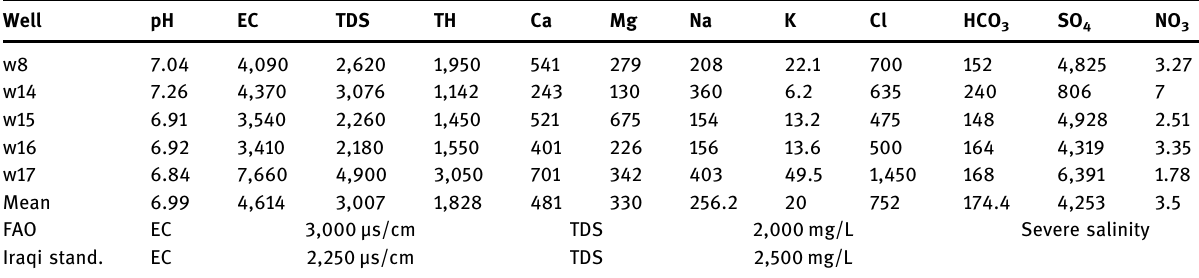
Table 7: Chemical data of the wells